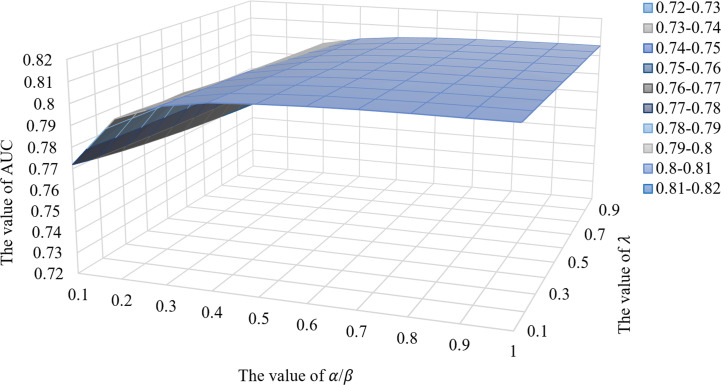
The performance influence of IRNMF parameter.